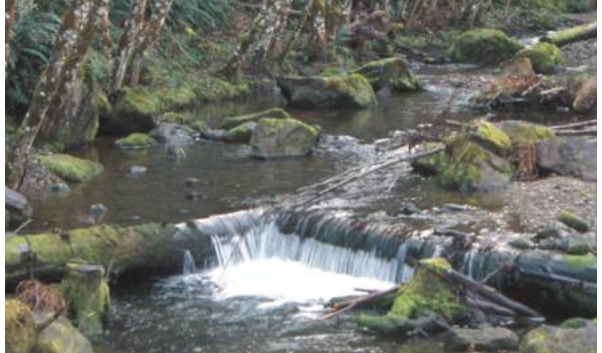
Figure 10. Rock weir.